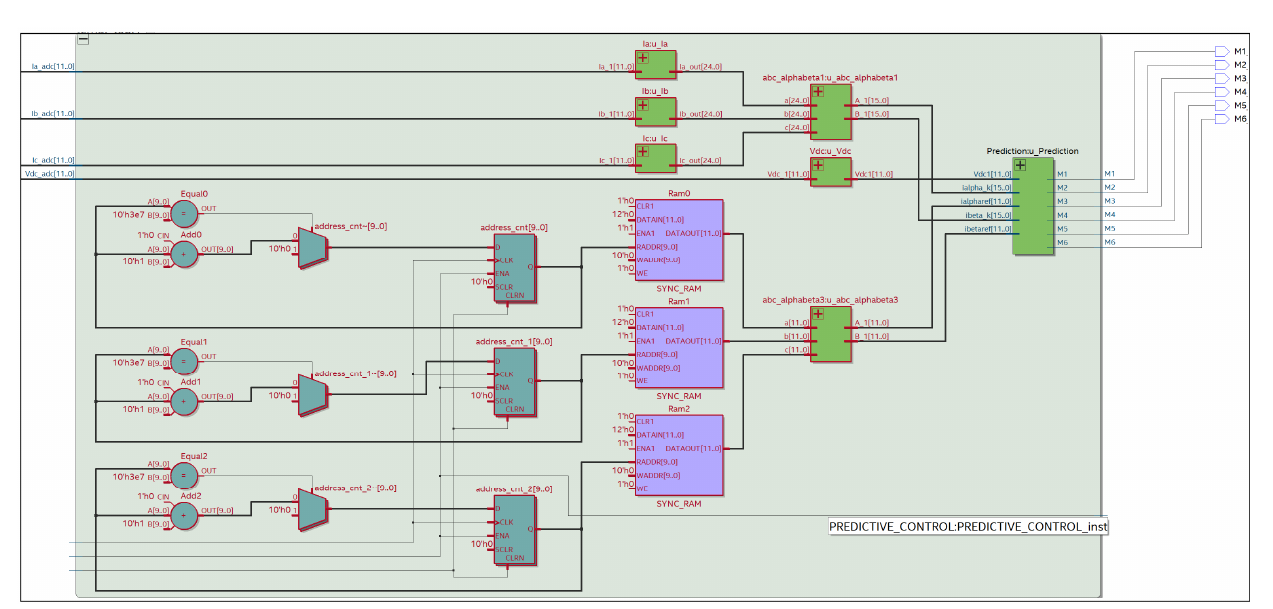
Figure 21. RTL view of the prediction and optimization stage.